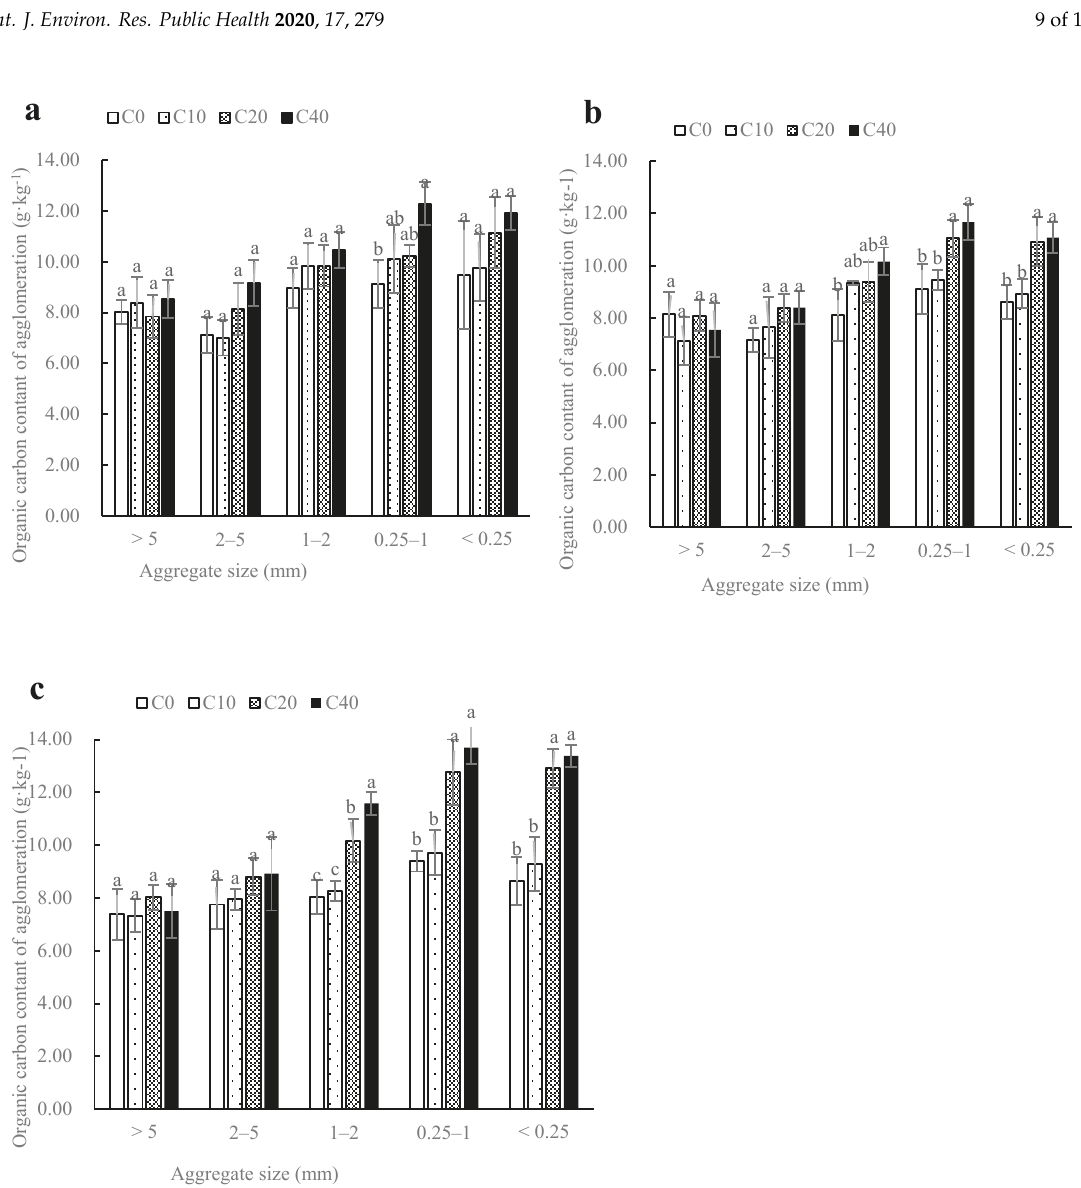
Figure 1. The content and distribution of organic carbon in mechanical-stable aggregates in the soil with biochar combined with conventional nitrogen application ( a ), 80% of conventional nitrogen application ( b ) and 60% of conventional nitrogen application ( c ). Different lowercase letters indicate significant differences among biochar treatments at the same nitrogen fertilizer at LSD 0.05.